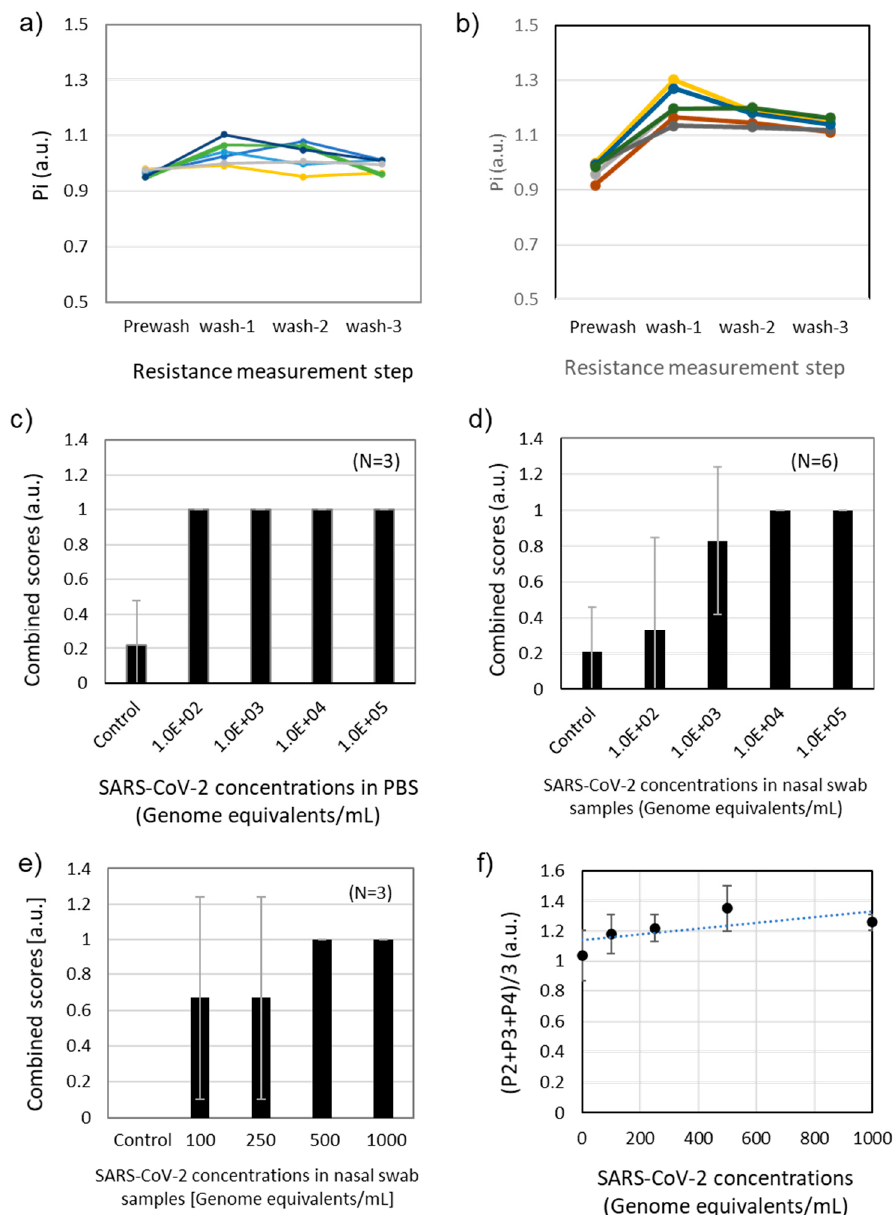
Figure 5. ( a ) Pi changes for negative nasal swab samples (N = 6). ( b ) Pi changes for nasal swab samples spiked with SARS-CoV-2 (1000 genome equivalents/mL). (N = 6) ( c ) Combined scores for various concentrations of SARS-CoV-2 in 1 × PBS (N = 3). Negative control (N = 9) ( d ) Combined scores for various concentrations of SARS-CoV-2 in nasal swab samples (N = 6 for positive samples, N = 12 for negative controls). ( e ) Dose response tests for estimating the limit of detection in nasal swab samples spiked with SARS-CoV-2. The concentrations of SARS-CoV-2 are 0, 100, 250, 500, and 1000 genome equivalents/mL (N = 3). ( f ) Average values of P2, P3, and P4 for the SARS-CoV-2 at the concentrations of 0, 100, 250, 500, and 1000 genome equivalents/mL in nasal swab samples (N = 3). If the combined score of C 1 + C 2 was equal to 1, it was positive. If the combined scores were 0 or 0.5, it was